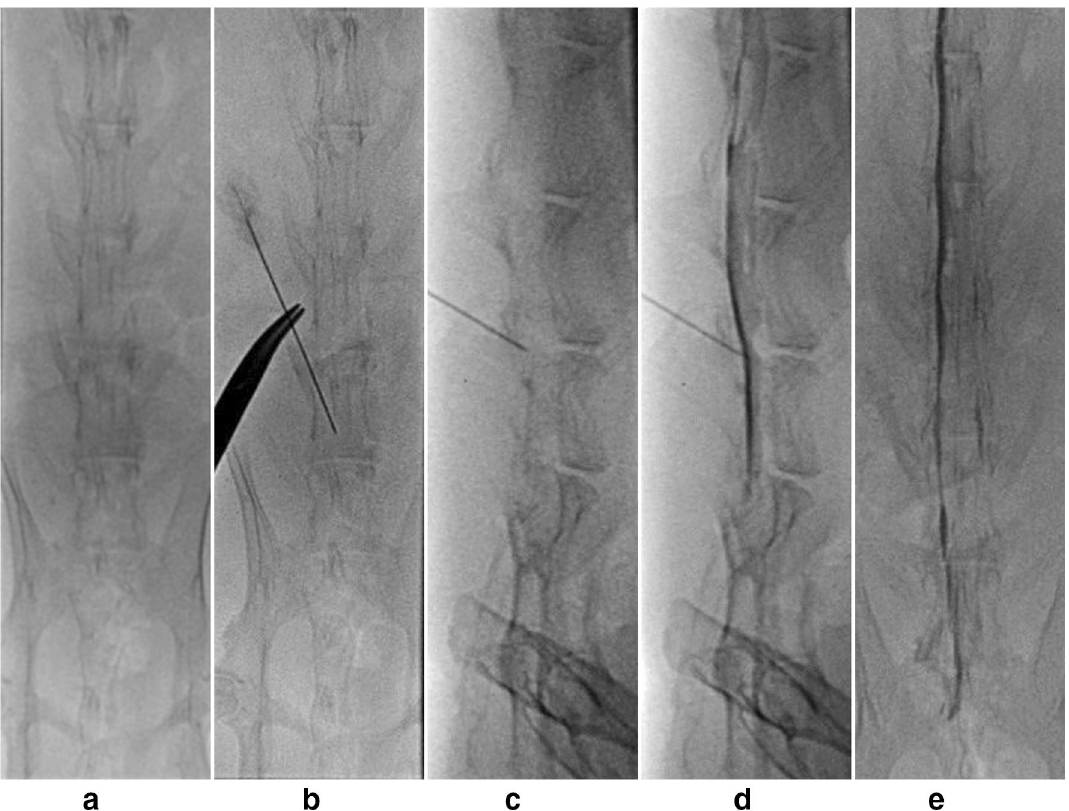
Figure 3. Epidural steroid injection via the interlaminar route. ( a ) Adequately anesthetized rabbit is placed on a fluoroscopy procedure table in the prone position. ( b , c ) Epidural injection is administered at the L6/L7 vertebral segment under fluoroscopic guidance. The targeted level is confirmed on both lateral ( d ) and anteroposterior ( e ) views.